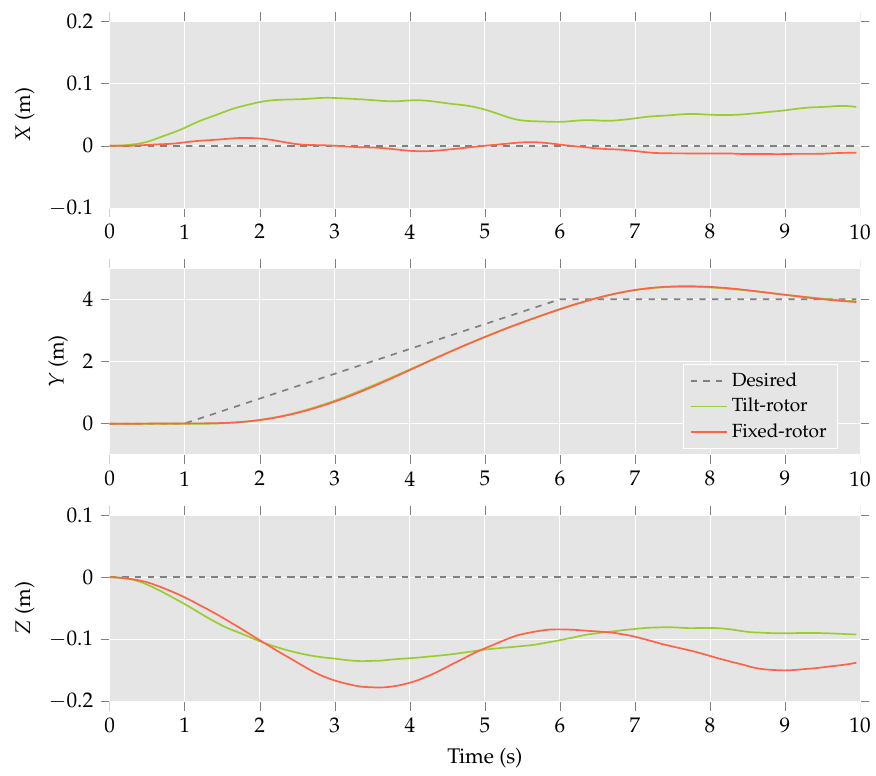
Figure 9. Multirotor helicopter position throughout the first maneuver.